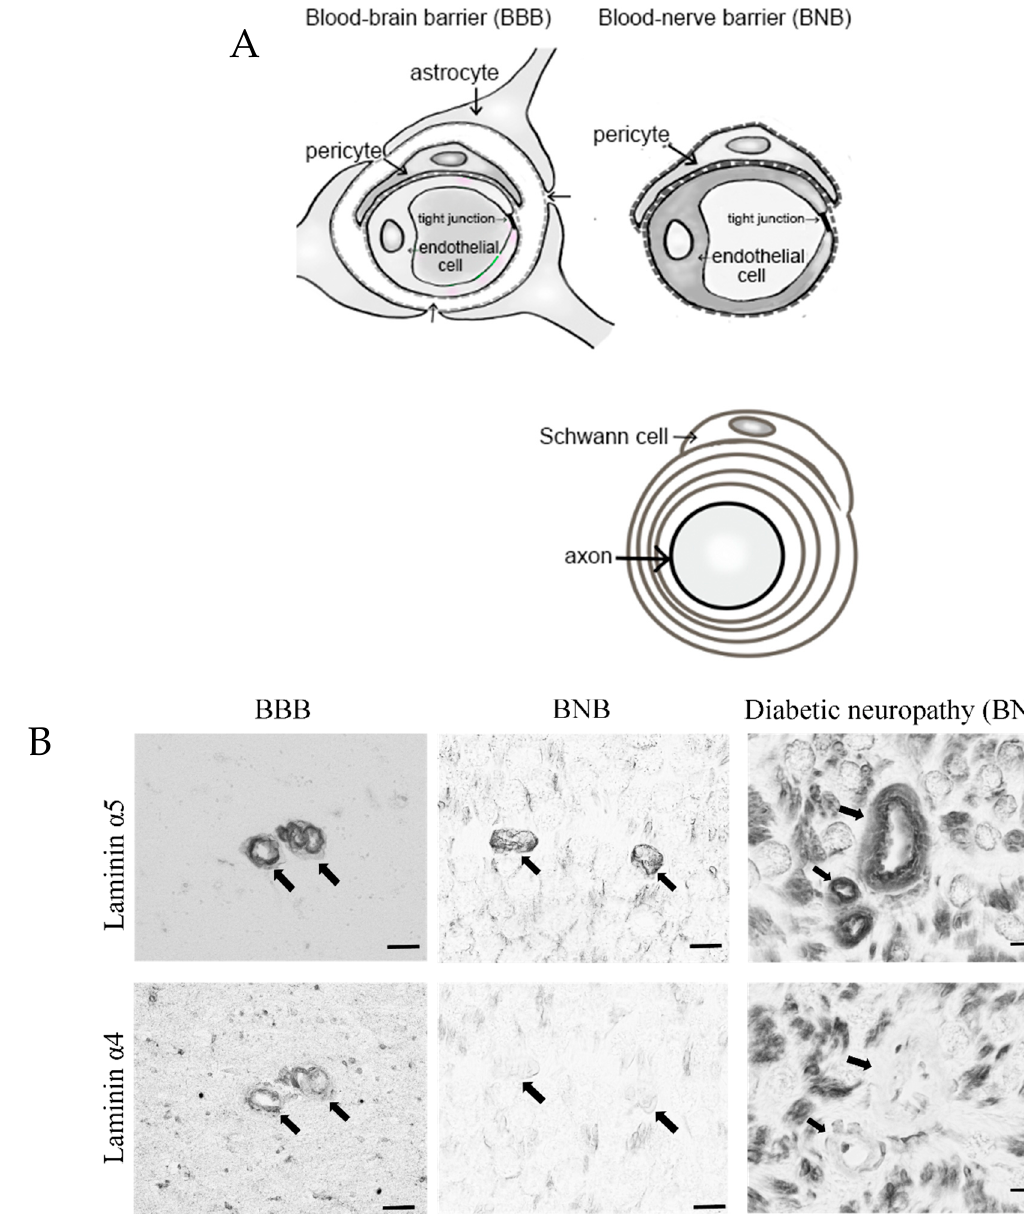
Figure 1. Comparative anatomy of the blood–brain barrier and blood–nerve barrier. ( A ) Peripheral nerve tissue consists of the blood–nerve barrier and axons of neurons wrapped in Schwann cells. Unlike the blood–brain barrier, which consists of vascular endothelial cells, pericytes, astrocytes, and basal laminae, the blood–nerve barrier consists of vascular endothelial cells, pericytes, and basal laminae. ( B ) Immunostaining with anti-laminin ( α 5 and 4) in the blood–brain barrier (BBB; brain; left panel) and blood–nerve barrier (BNB; median nerve; middle panel) from a postmortem 67-year-old man with amyotrophic lateral sclerosis and from a 67-year-old man with diabetic peripheral neuropathy (DPN; sural nerves; right panel). Laminin α 5 immunoreactivity was localized to the microvessels. Only laminin α 4 immunoreactivity was lost in the BNB. Bar 10 μ m.